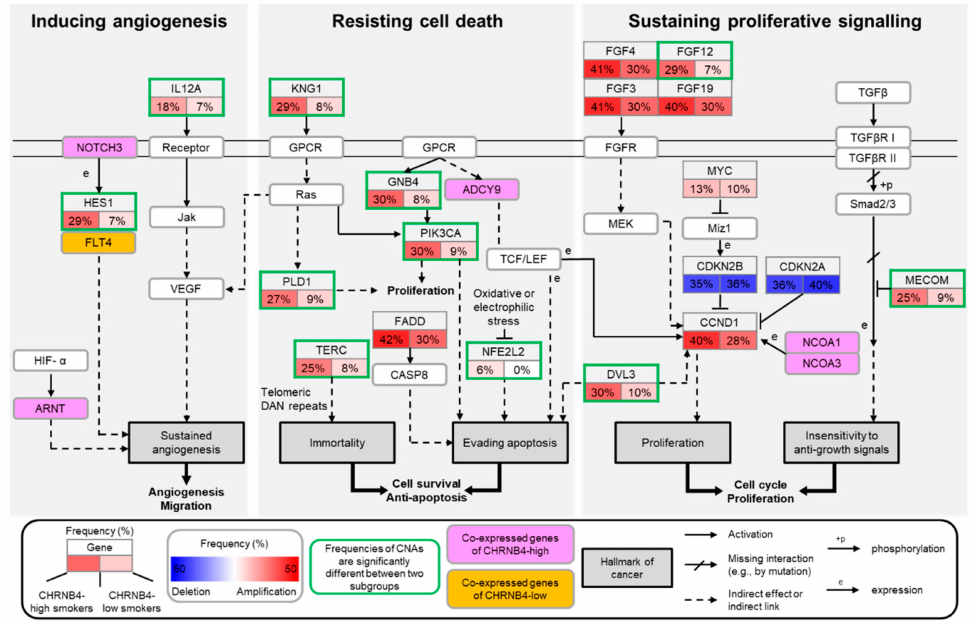
Figure 5. Graphic illustration of the identified genes, functions, and pathways of tumorigenesis